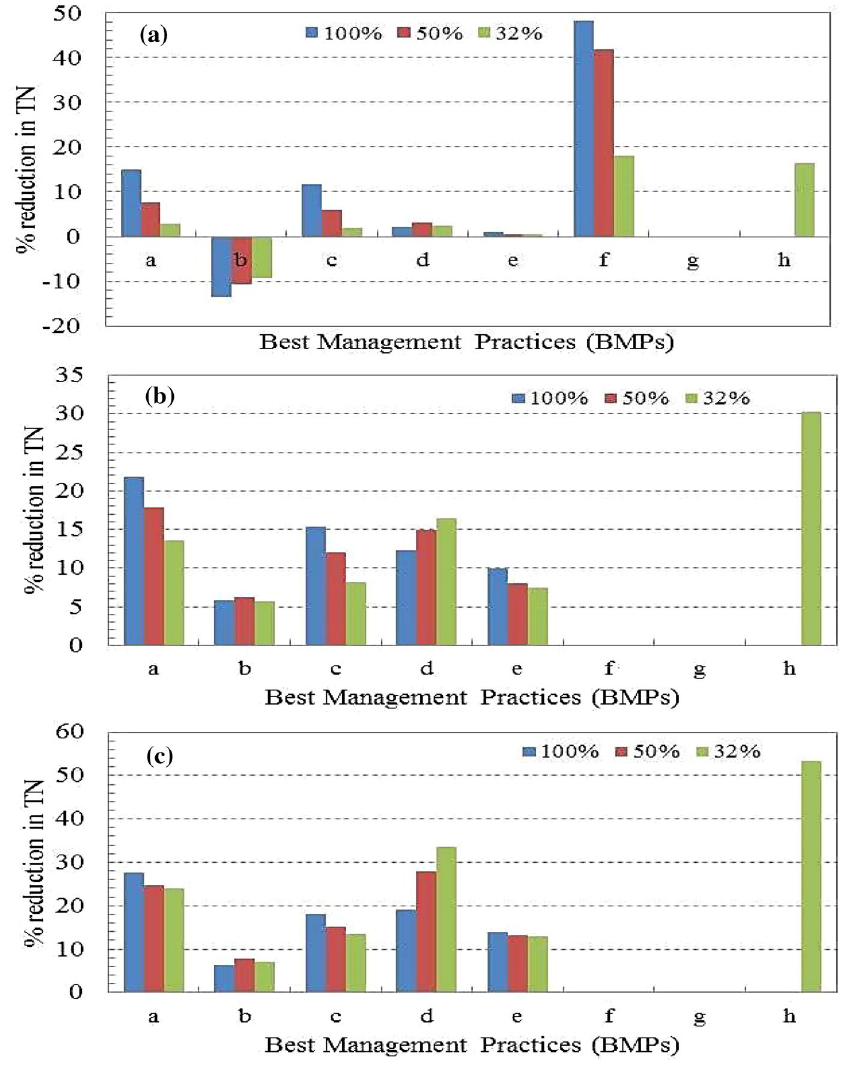
Fig. 9 TN declination in percent for various percentage of varied-crop region treated a at watershed level, b at sub-water- shed level and c at HRS